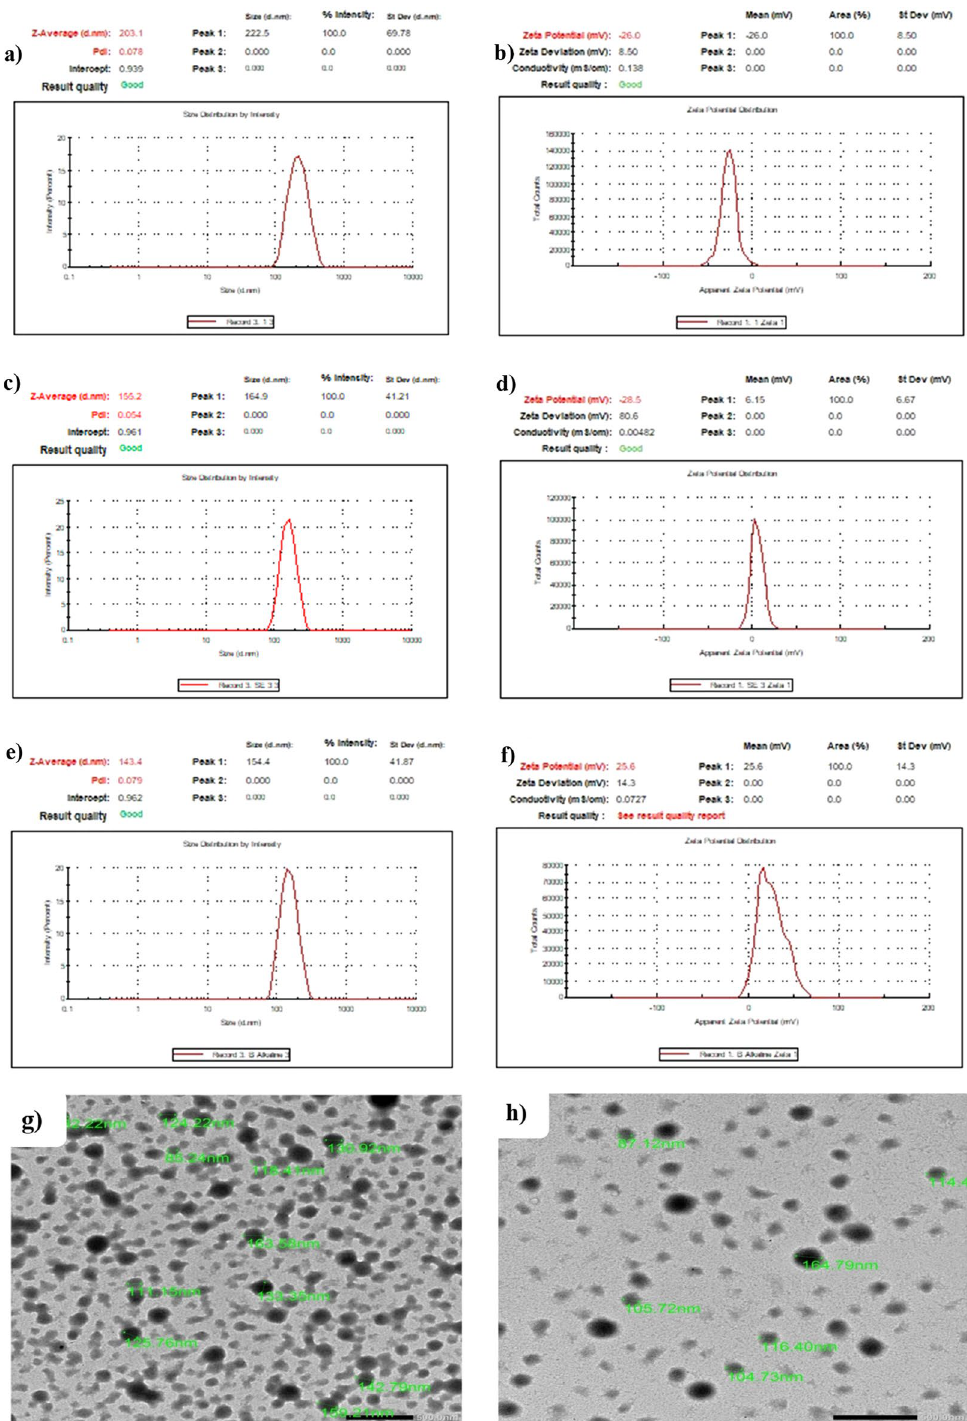
Figure 1. The hydrodynamic particle size diameter (nm), PDI, and zeta potential (mV) of neutral BBR-BSA NPs ( a , b ); alkaline BBR-BSA NPs ( c , d ); alkaline BSA NPs ( e , f ). The TEM photomicrographs of alkaline BBR- BSA NPs, magnification = 10,000 × ( g ); alkaline BSA NPs, magnification = 12,000 × ( h ). (Scale bar is 500